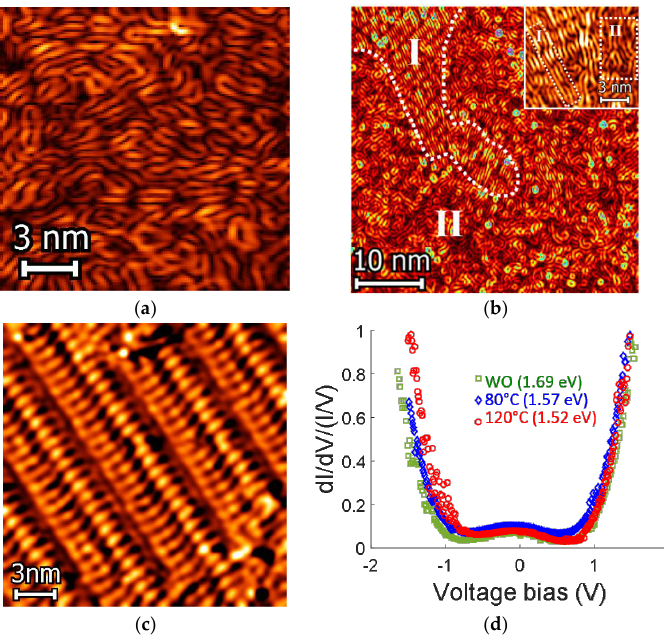
Figure 2. Scanning tunneling microscopy (STM) and spectroscopy (STS) of DRCN5T films analysis at di ff erent temperatures: ( a ) Without thermal annealing (WO), i.e., room temperature; tunneling conditions: It = 200 pA, U = 850 mV, ( b ) TA@80 ◦ C, inset shows di ff erent reordering (structure I and structure II); tunneling conditions: It = 200 pA, U = 850 mV, ( c ) TA@120 ◦ C; tunneling conditions: It = 200 pA, U = 950 mV, ( d ) Local density of states (LDOS) showing average electronic band